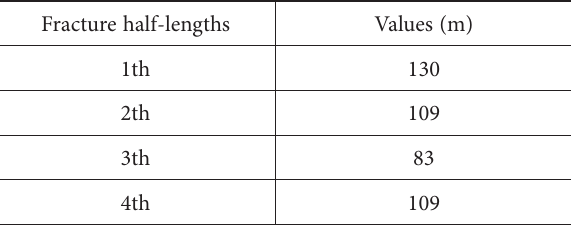
Table 4. Saiping 1 fracture half-lengths